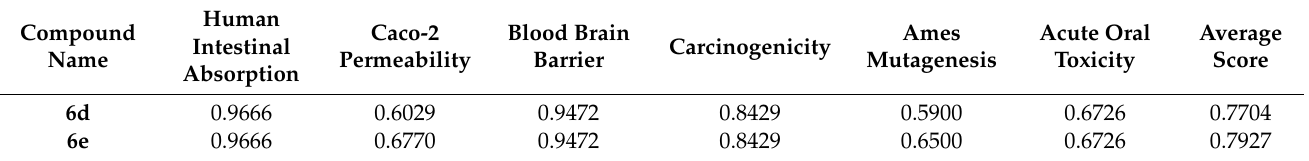
Table 4. ADMET score for human intestinal absorption, Caco-2 permeability, blood brain barrier, carcinogenicity, ames mutagenesis and acute oral toxicity as calculated by